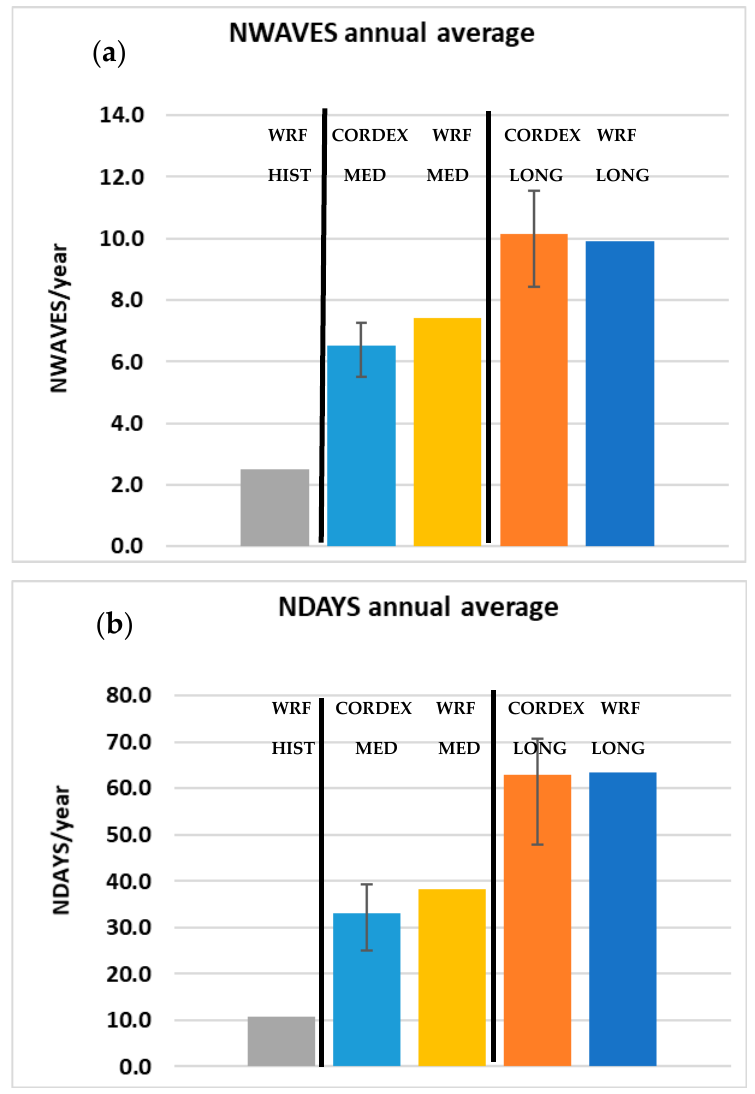
Figure 10. Annual average of ( a ) NWAVES and ( b ) NDAYS for WRF HIST, MED and LONG and CORDEX average, maximum and minimum for MED and LONG. NWAVES: Number of HW.